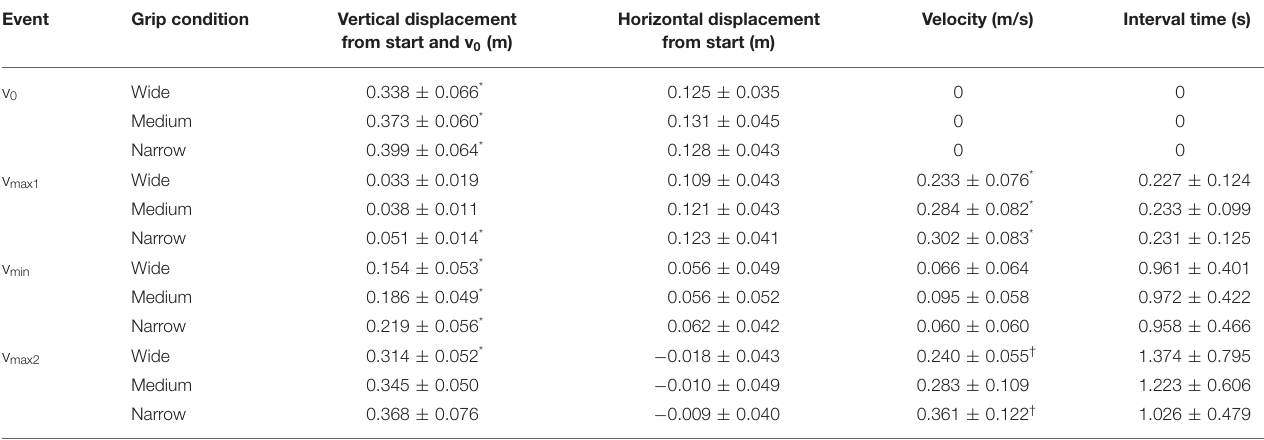
Horizontal displacement Velocity (m/s) Interval time (s) from start and v 0 (m) from start (m)